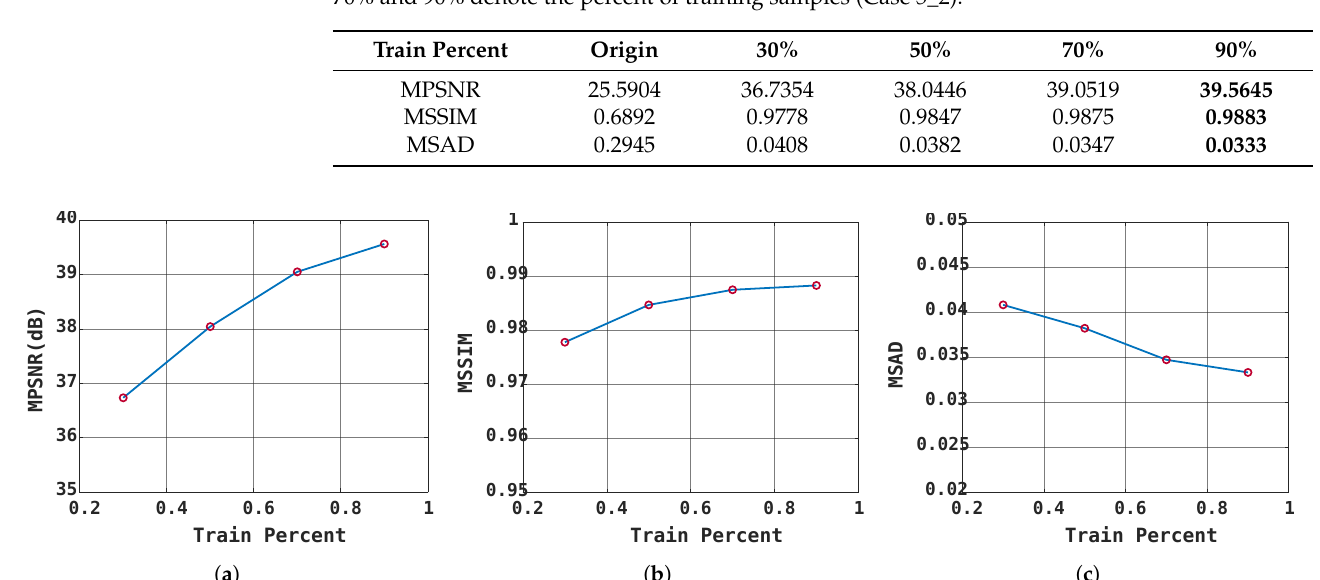
Table 4. Quantitative evaluation of the ablation experiment: training percent, where 30%, 50% and 70% and 90% denote the percent of training samples (Case 5_2).